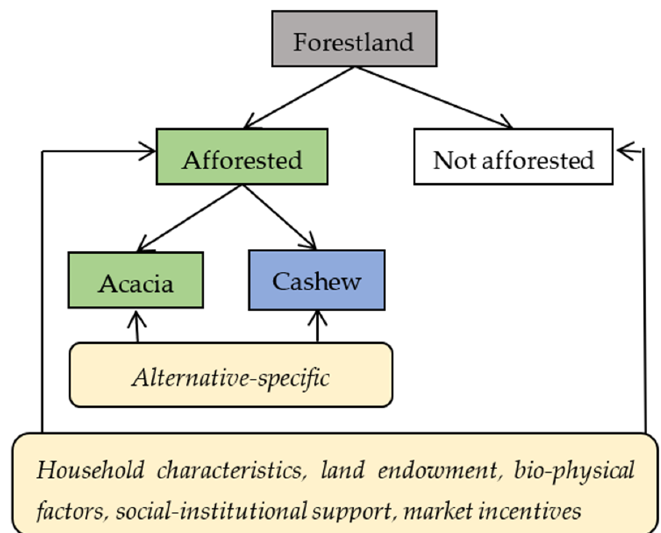
Figure 2. Logit tree of land use action ‐ species choice.